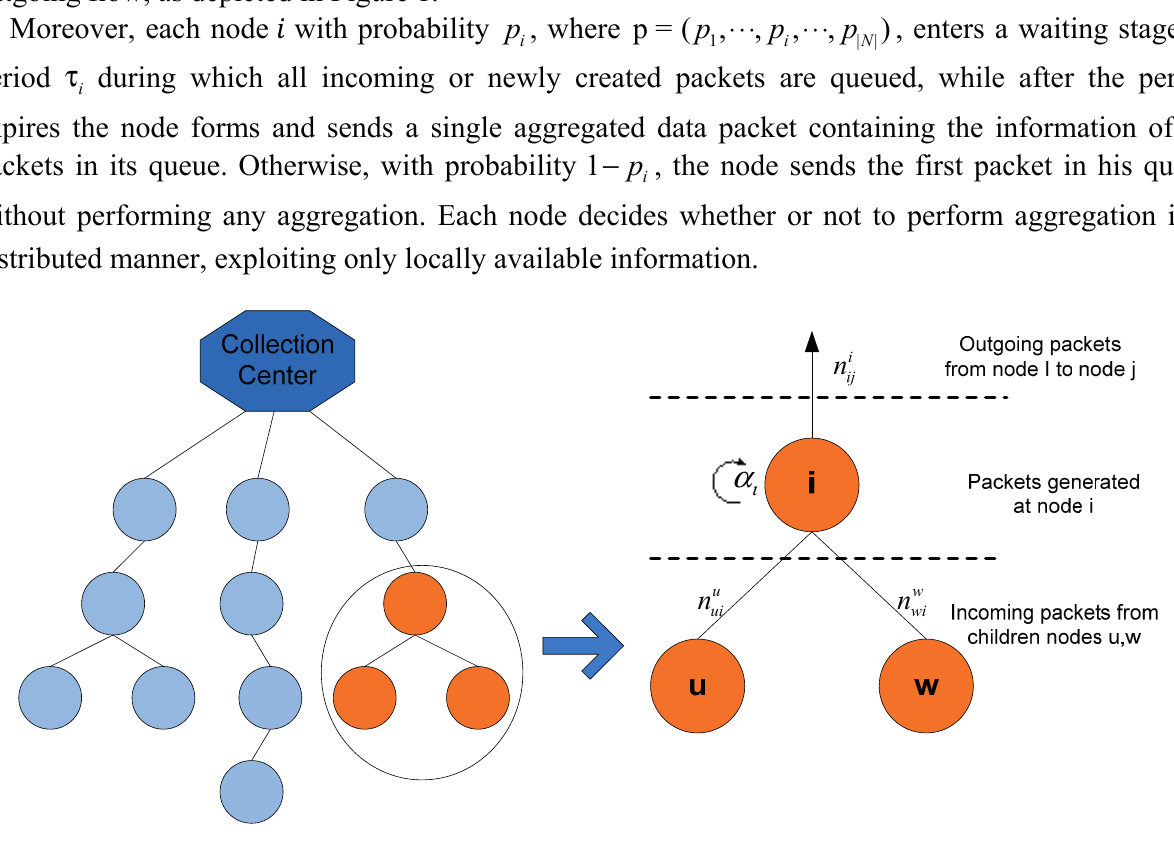
Figure 1. Data aggregation procedure in data gathering